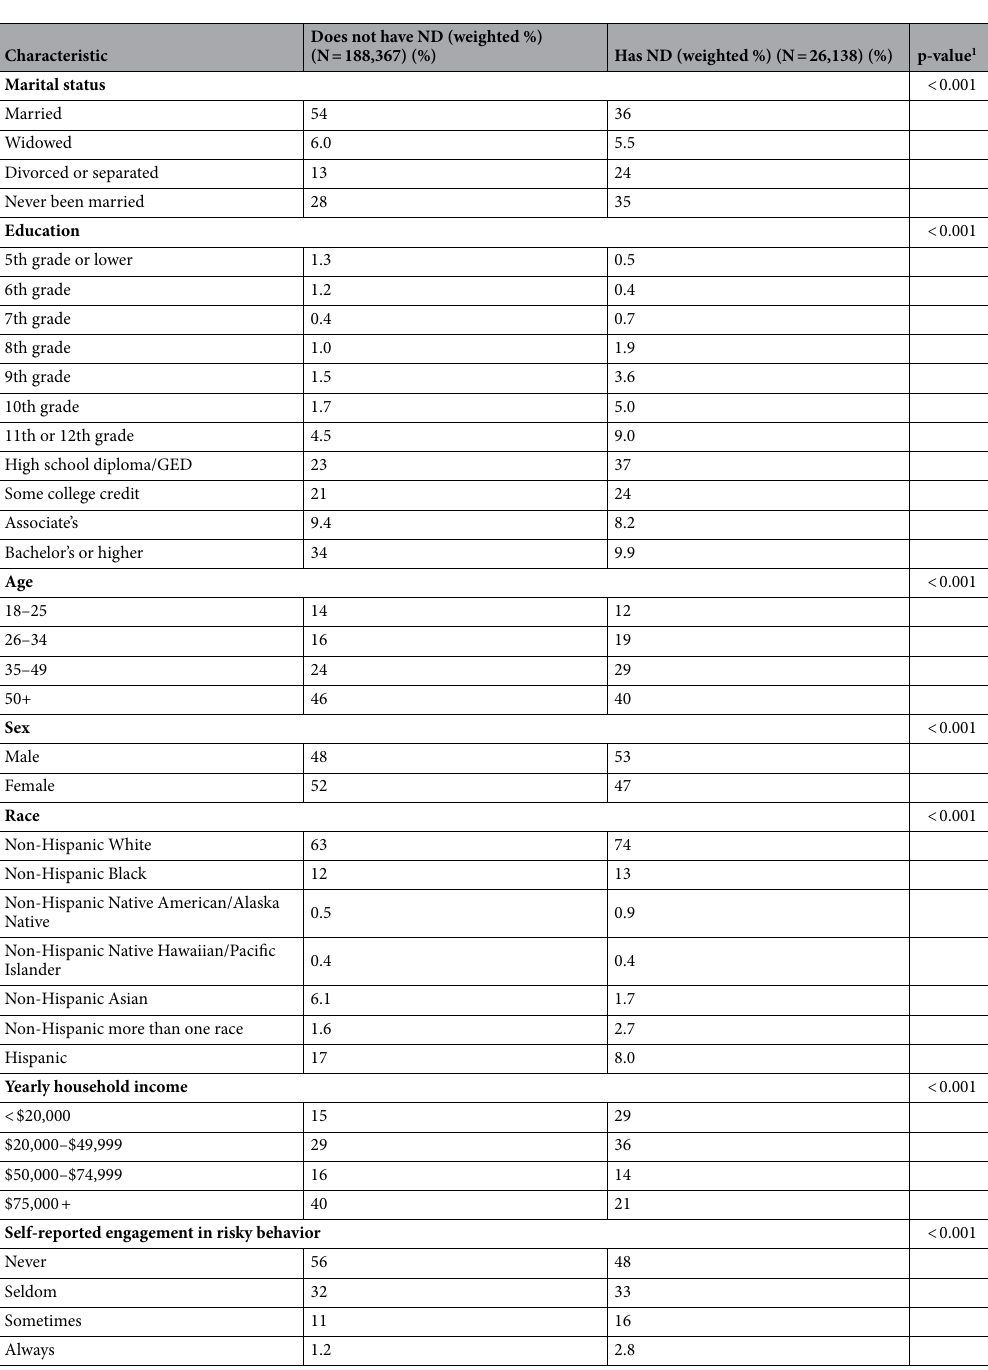
Table 1. Demographic characteristics of those with and without nicotine dependence (ND). ND Nicotine Dependence. 1 Chi-squared test with Rao & Scott’s second-order